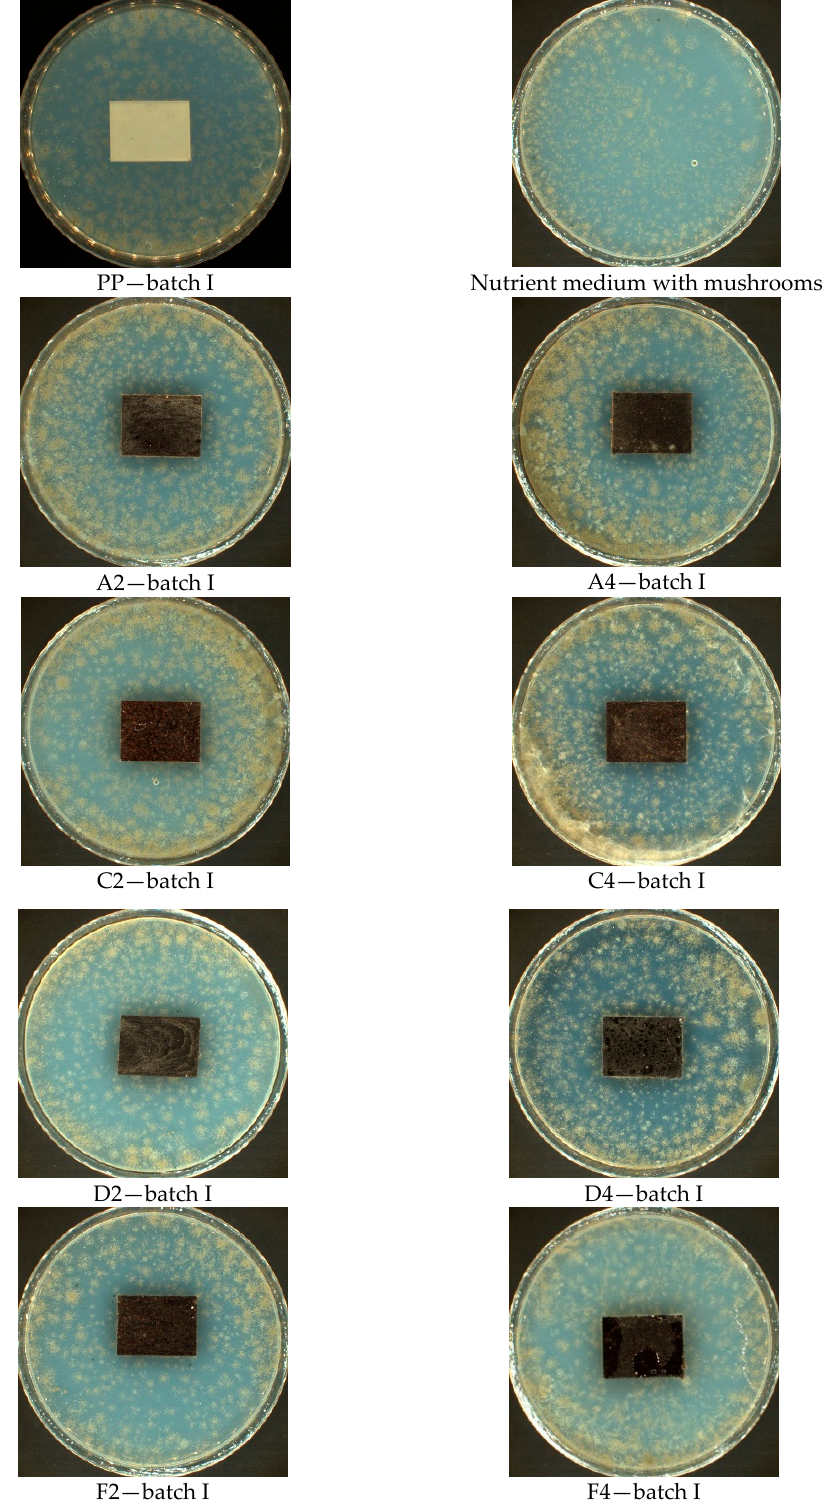
Figure 3. Method A—results of visual assessment of samples; photos of batch samples: I.